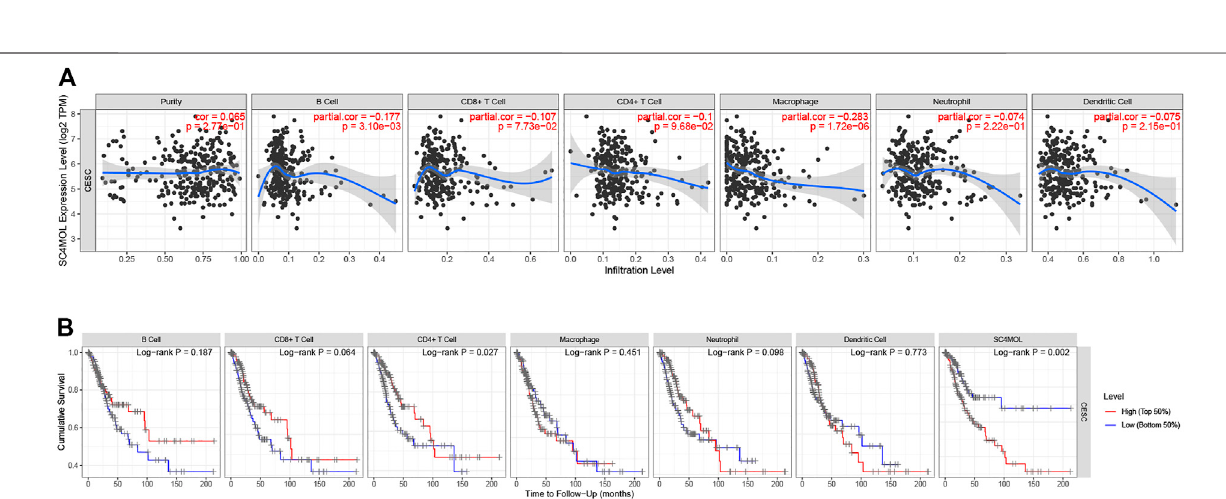
Frontiers in Genetics |